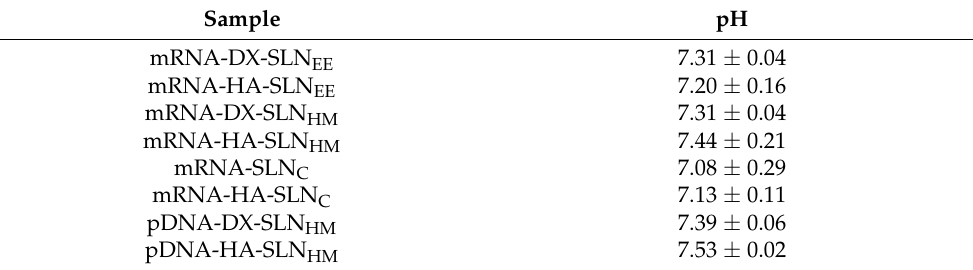
Table 5. pH measurements of mRNA- and pDNA-based vectors.